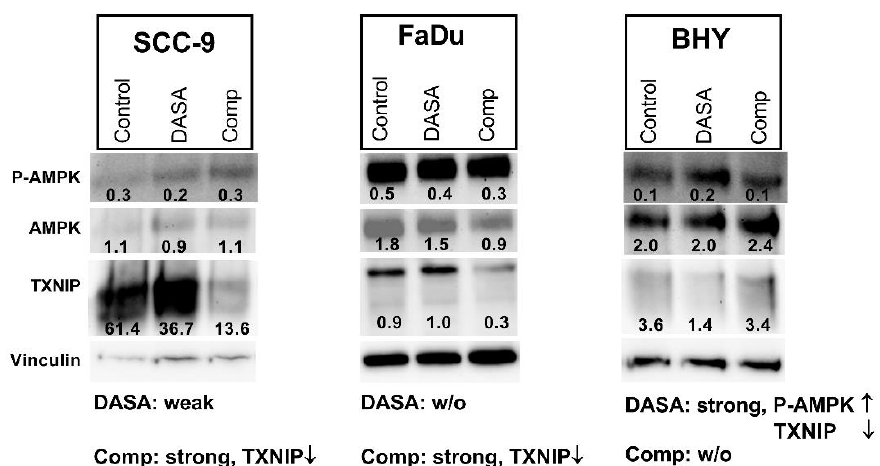
Figure 6. Influence on P-AMPK and TXNIP levels. Western blot of cell lysates after 24 h of treatment with 10 µ M DASA-58 (DASA), 10 µ M Compound 3k (Comp) or with vehicle only (Control). Num- bers indicate ratios of band intensity to intensity of corresponding Vinculin band. The inscription below outlines the metabolic effects of the substances as given in Tables 1 and 2 (weak, strong, w/o : with- out effect) combined with observed changes in depicted Western blots ( ↑ : intensity is increased, ↓ : intensity is decreased upon treatment). Shown is one representative result out of three.